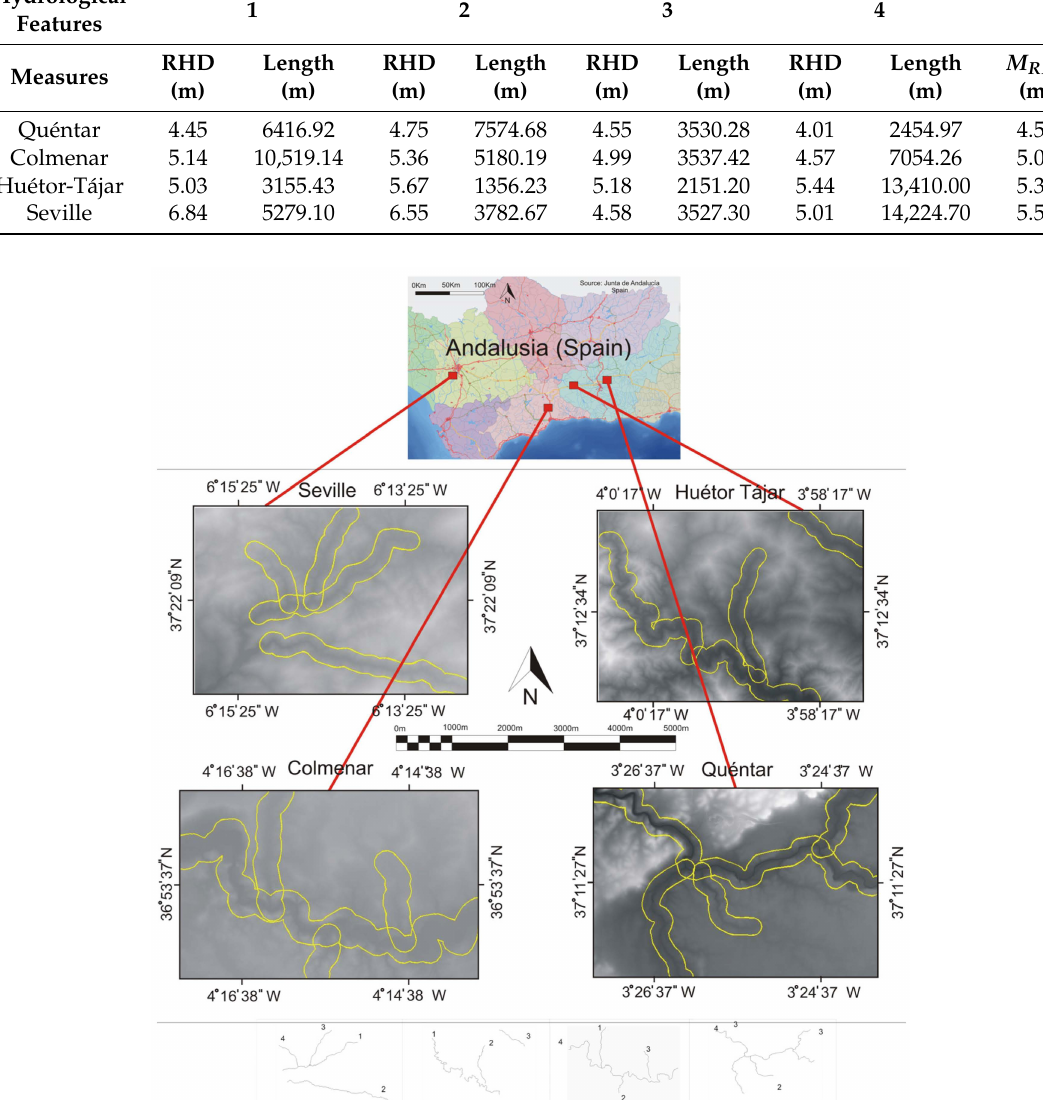
Figure 4. Sample DEMs (four different places) and distribution of the digitized linear hydrological features. Surrounding each hydrological feature is a buffer 600 m